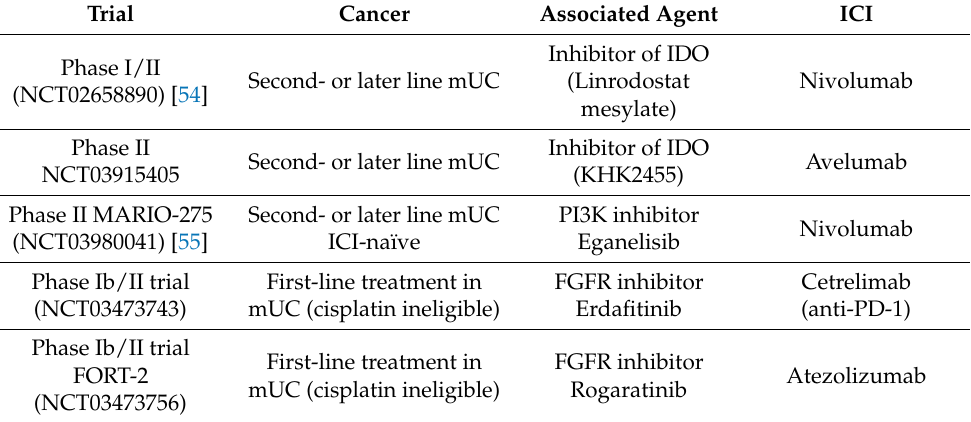
Table 2. Overview of important trials evaluating potential combinations with immune checkpoint inhibitors in metastatic urothelial